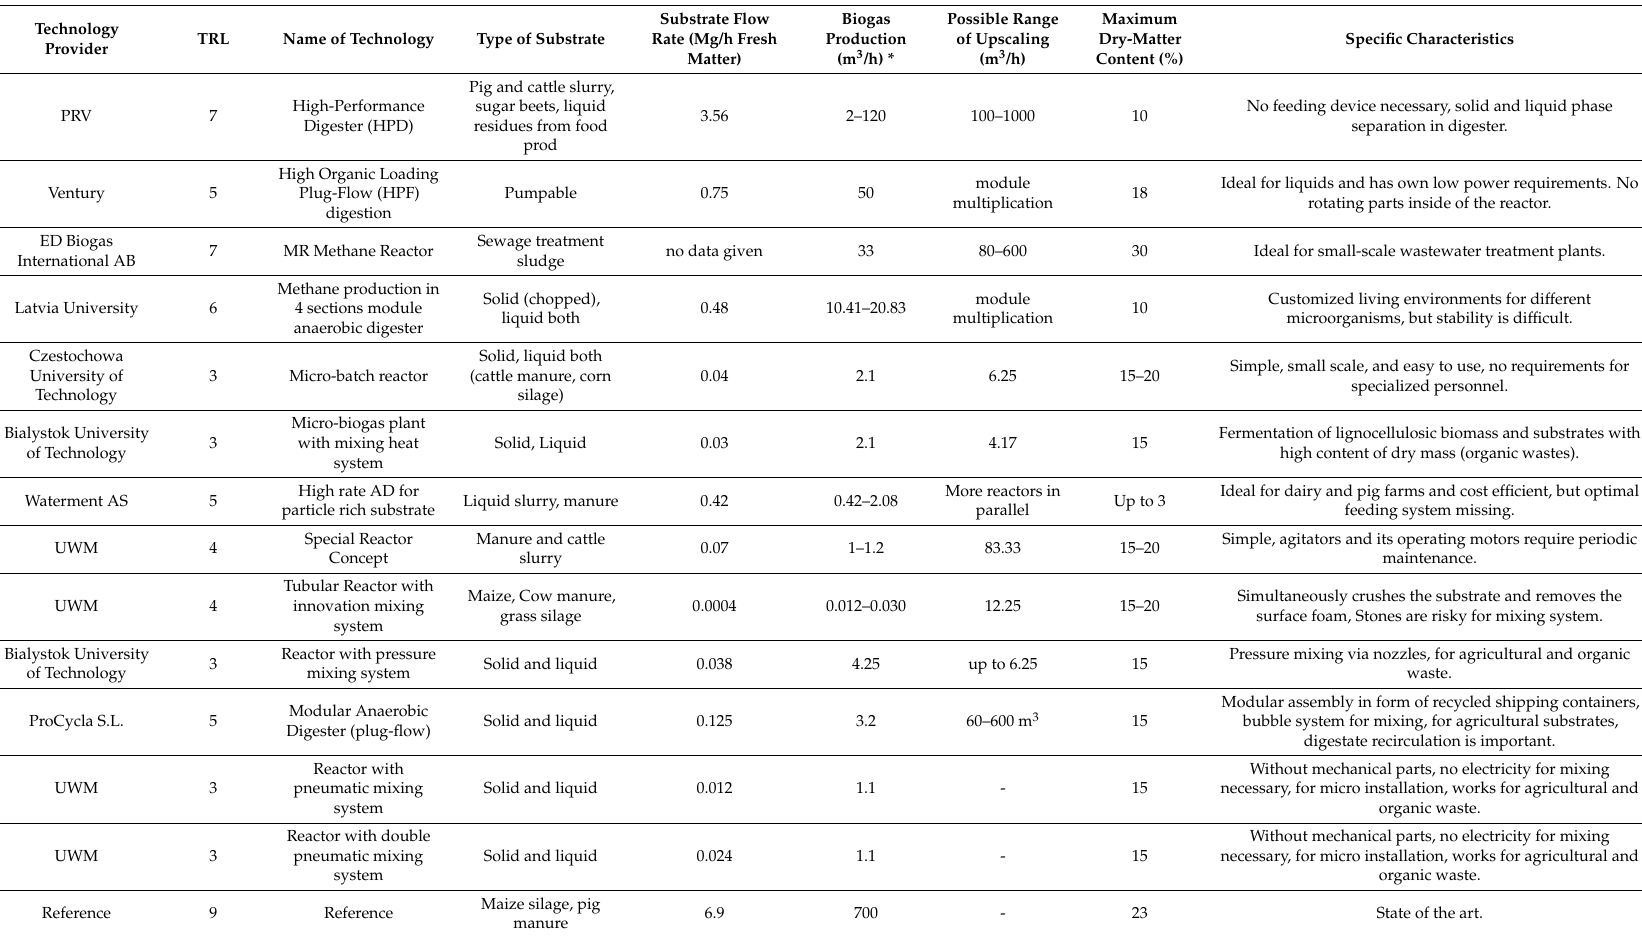
Table 4. Overview of selected data for digestion